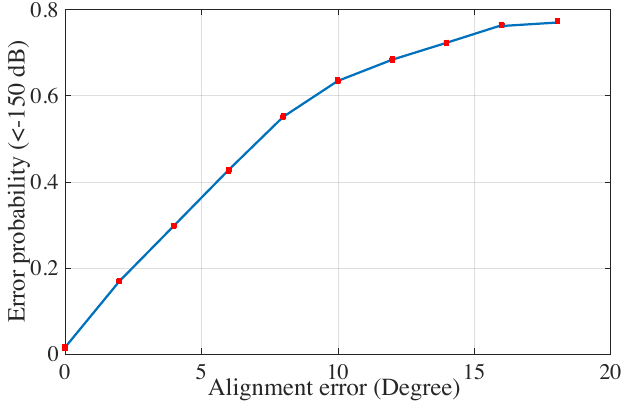
Figure 8. The relationship between the estimated angle error and received